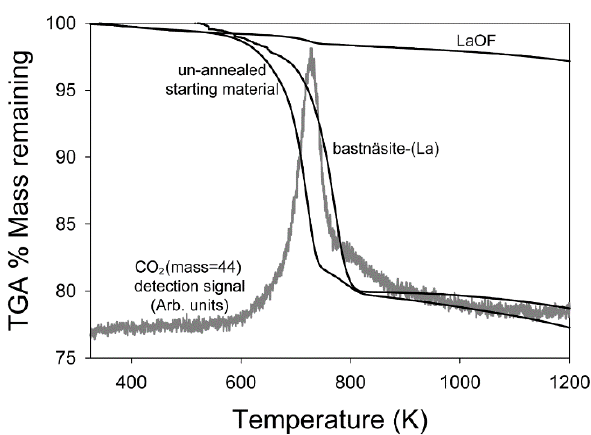
Figure 3. Thermogravimetric analysis (TGA) curves for annealed bastnäsite-(La), unannealed starting material, and LaOF from 325 K to 1223 K. CO 2 detection from the Pfeiffer Vacuum Thermostar Quadrupole mass spectrometer in light gray. Mass loss curves for the starting material and annealed bastnäsite-(La) begin to steepen at 600 K, at the same time CO 2 detection begins. The mass loss curve for LaOF does not show a significant change in slope, indicating that the decomposition reaction did not occur in that sample.